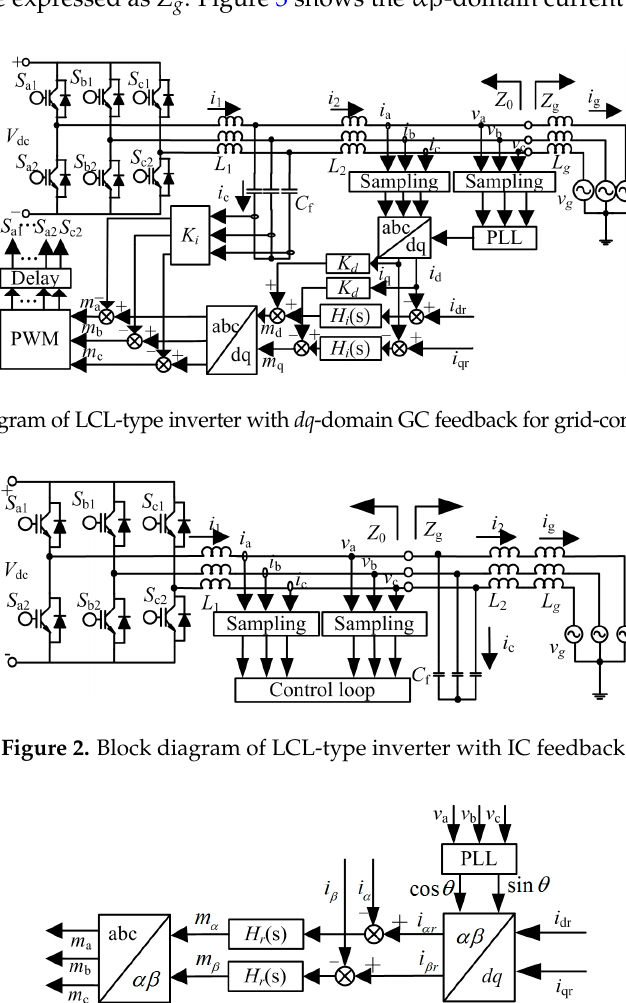
Figure 3. Block diagram of a current controller with αβ -domain current feedback.